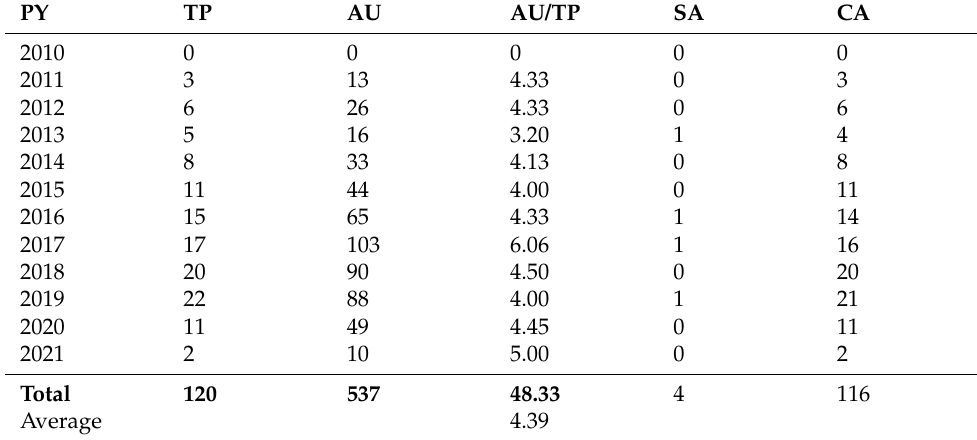
Table 6. Characteristics by Year of Publication Outputs from 2010 To